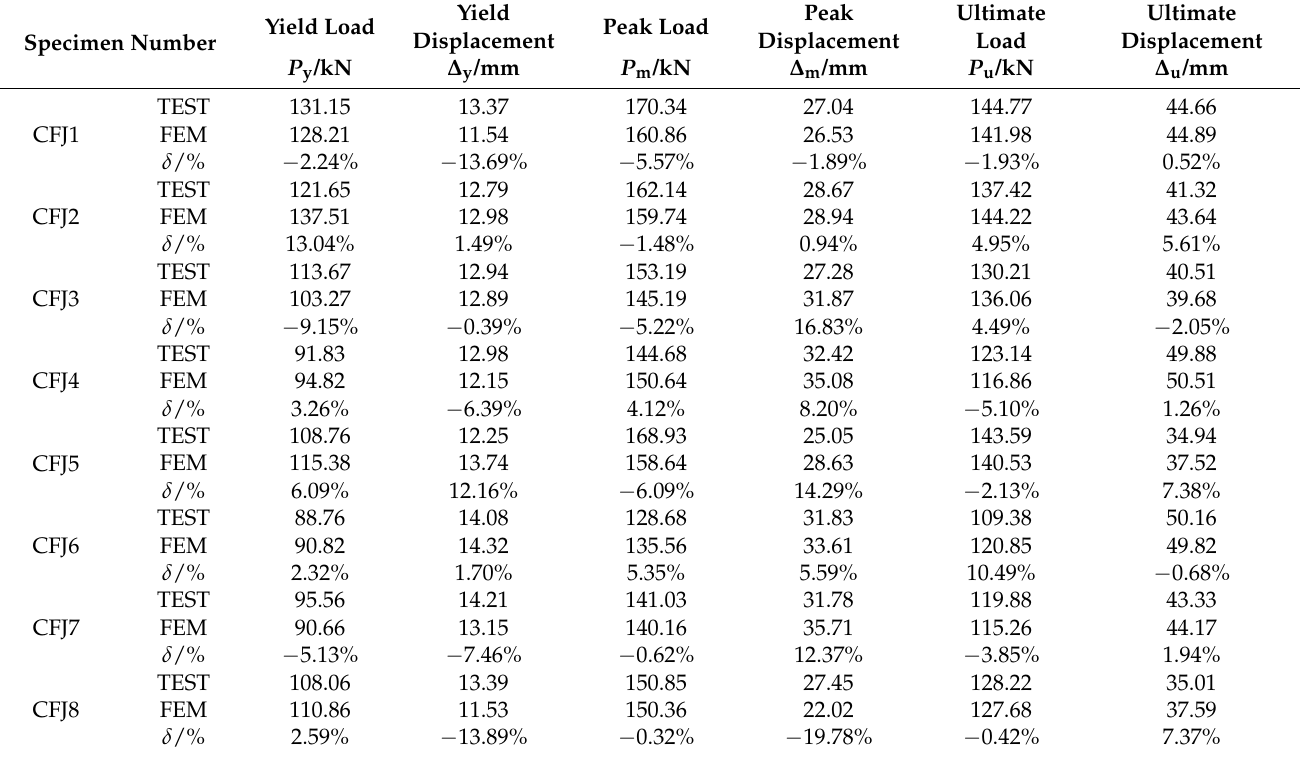
Table 4. Comparison of test and simulation results of bearing capacities and